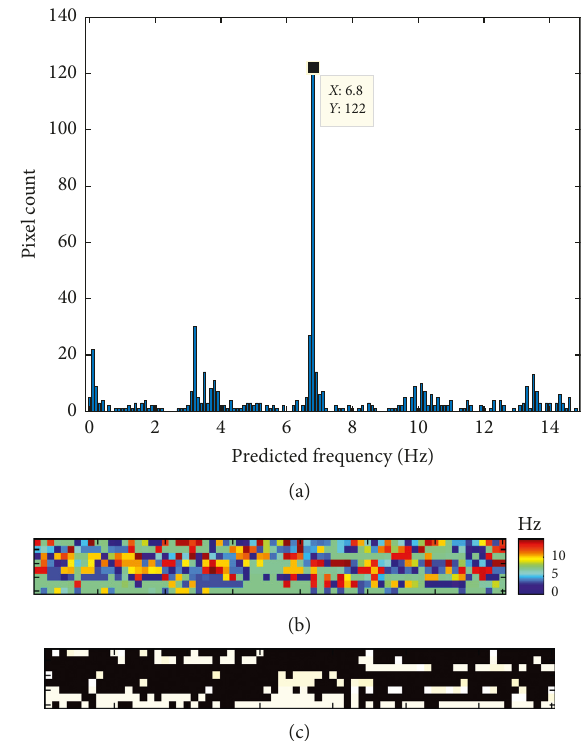
Figure 22: Simply supported carbon plate experimental case 2 result from the proposed method. (a) Histogram of predicted frequency distribution. (b) Predicted outputs visualization in their original spatial position. (c) Highlighted pixels predicted as 6.8Hz for verification.